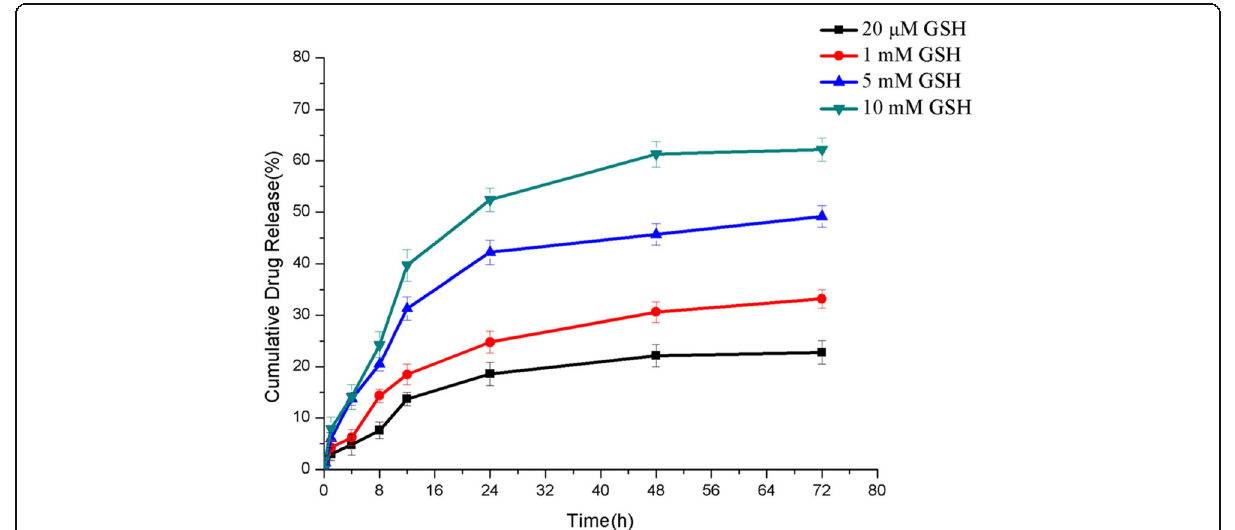
Fig. 7 Cumulative release of CUR from CUR-BCSC@PCs at different GSH conditions